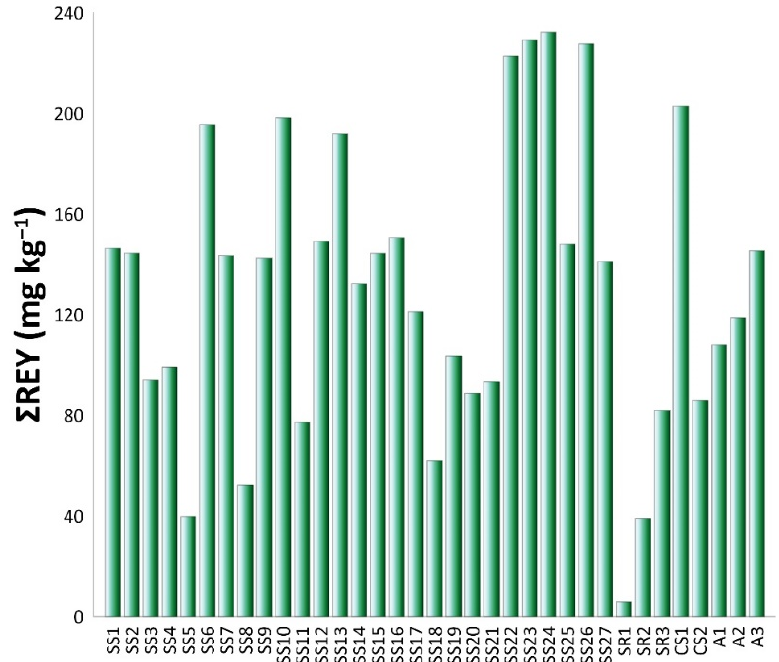
Figure 6. Spatial distribution of Σ REEs in soil samples (A1–A3; SS1–SS27), source rocks (SR1–SR3), and reference soils (CS1 and CS2).